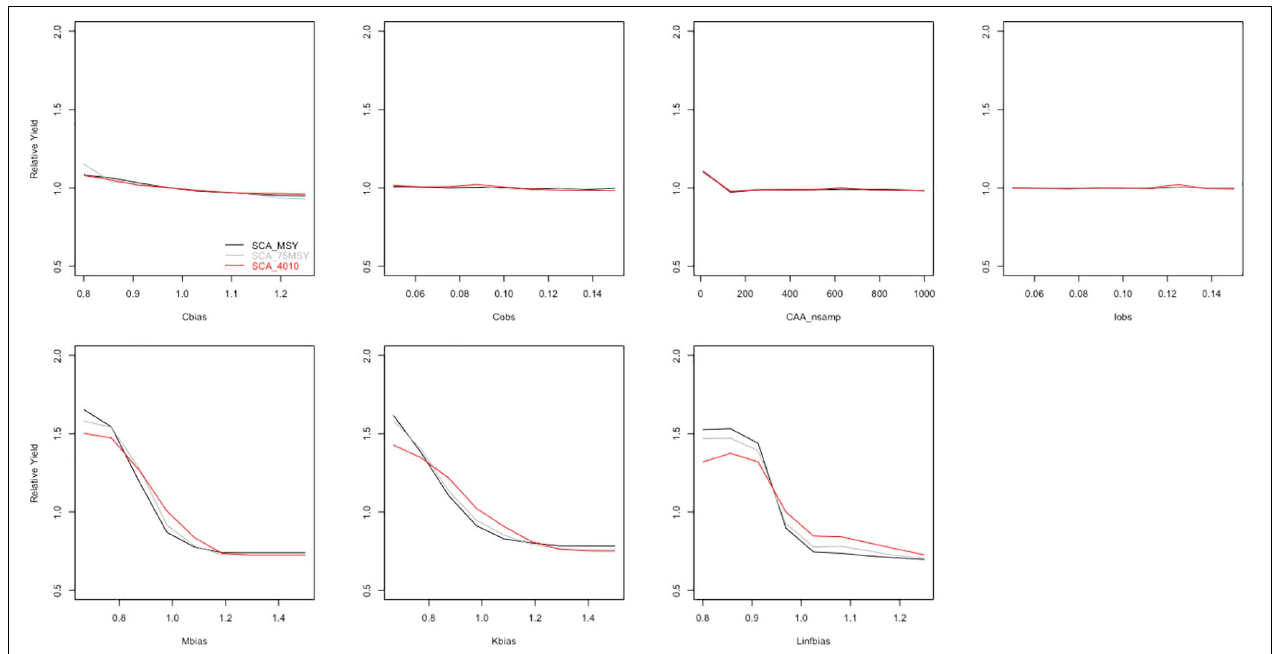
FIGURE 6 | Mean trend of all parameters conducted with three